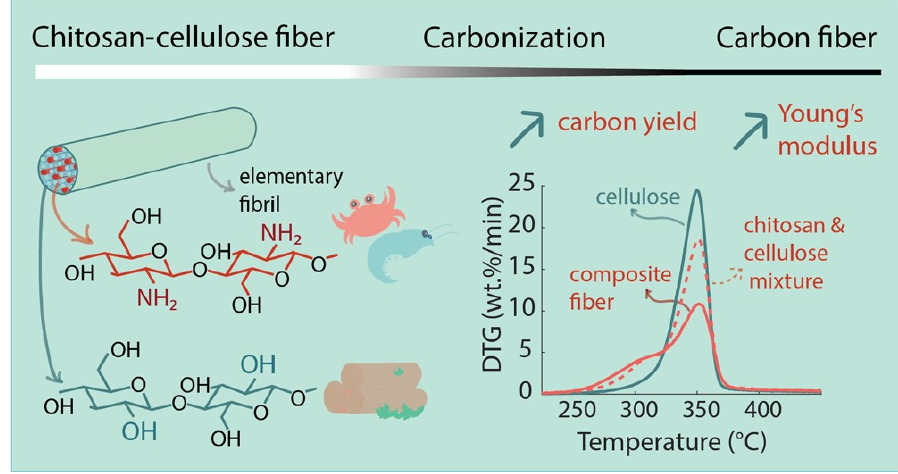
Figure 13. Preparation scheme of regenerated cellulose–chitosan fibres for improved carbon yield and structural properties of the respective carbon fibres [154] .